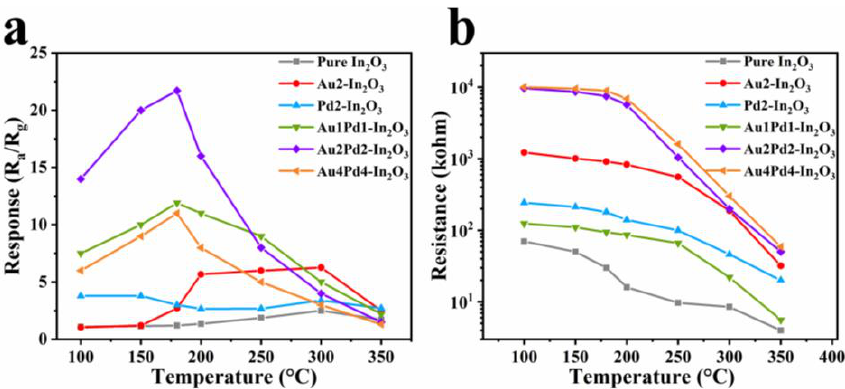
Figure 6. ( a ) Response values to 100 ppm CO gas; ( b ) baseline resistance values in air of nanofiber gas sensors based on six samples at different operating temperatures.